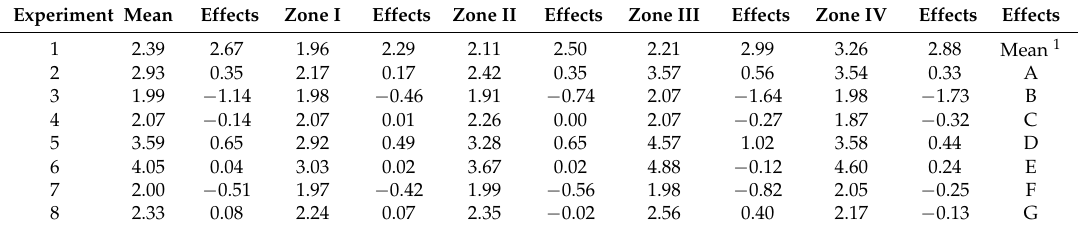
Table 9. Calculation of the Effects by means of Yates’ Algorithm, for Feret max/Feret min, F max /F min . Experiment